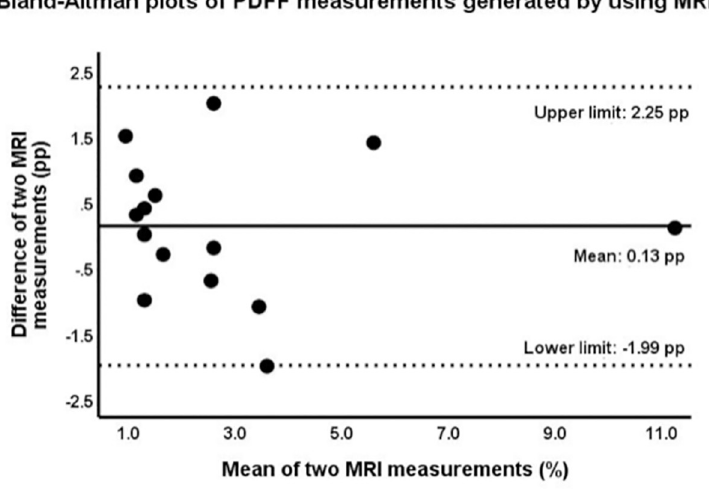
Fig 7. Bland-Altman plots for variability of PDFF measurements generated using